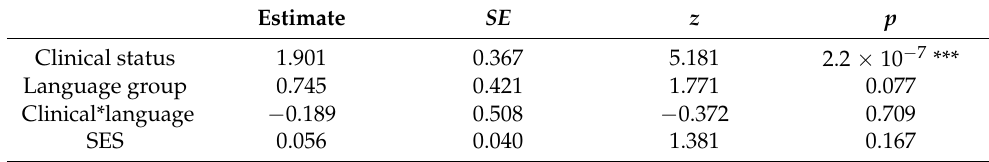
Table 6. Language-dependent part: outcome of the mixed-effect logistic regression analysis.